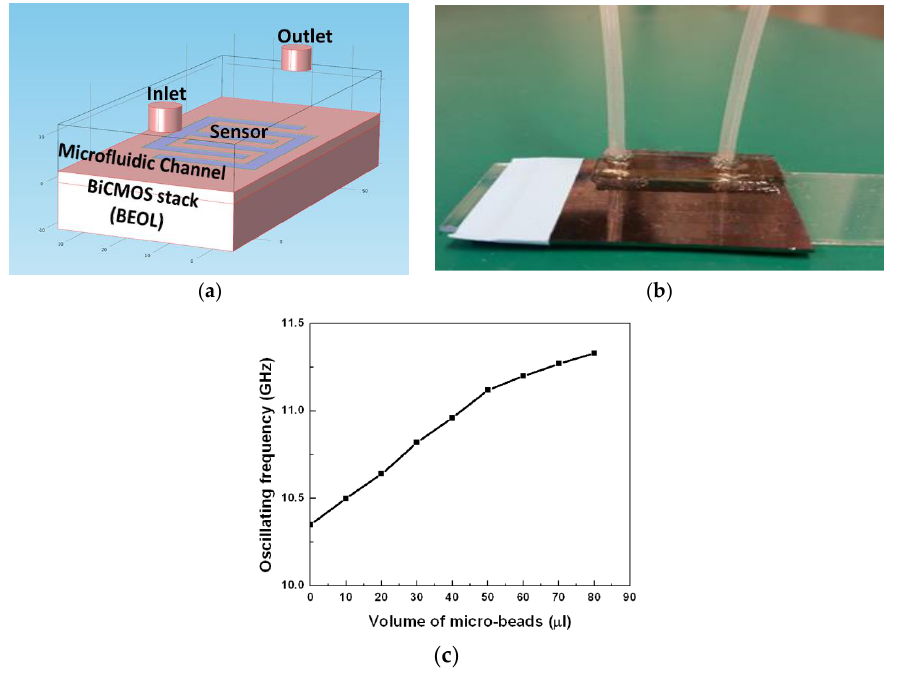
Figure 10. ( a ) Schematic of the microfluidic integration with the CMOS sensor; ( b ) CMOS sensor chip together with the polymer microfluidic; ( c ) Variation of the resonant frequency of the oscillator with different concentrations of particles in a suspension